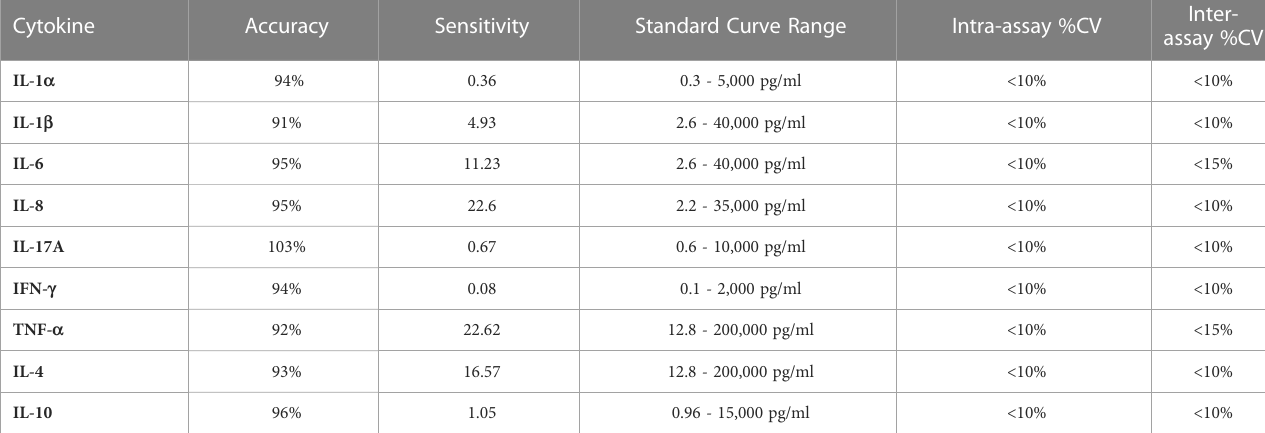
TABLE 3 Assay characteristics for all cytokines of MILLIPLEX ® bovine cytokine immunology multiplex assay (Cat. # BCYT1-33K).